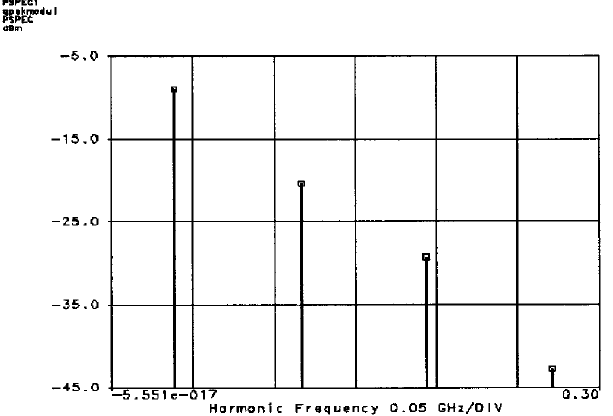
FIGURE 26 Discrete power spectral density of the periodic binary input signal.